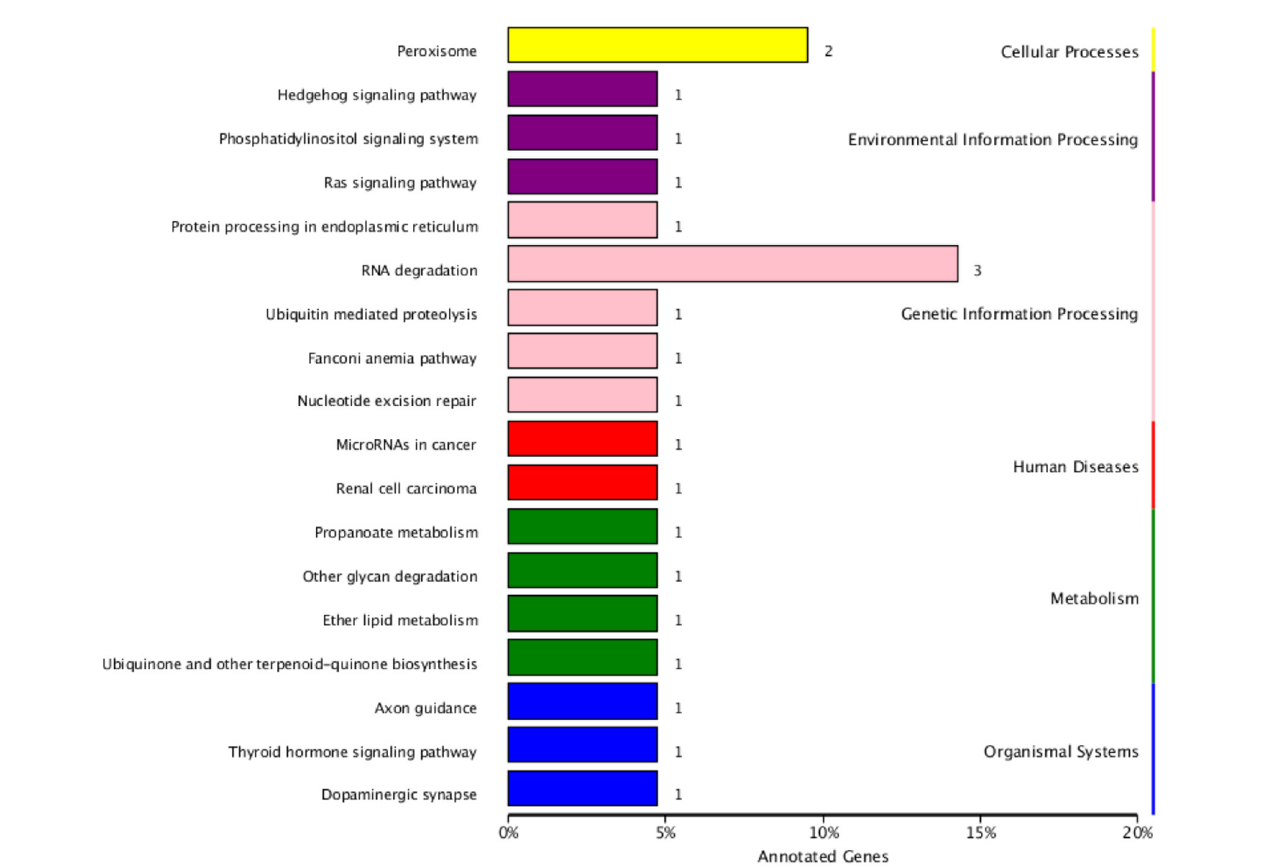
FIGURE8 KEGG classification of circRNA-derived genes. The ordinate is the name of KEGG metabolic pathway, and the abscissa is the number of circRNA source genes annotated to this pathway and their proportion in the total number of genes annotated.